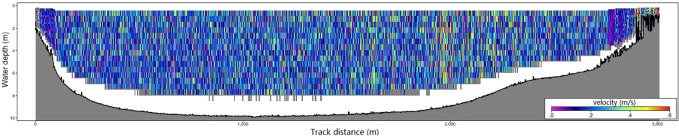
The current velocity of a transection in Haichaohe bay.